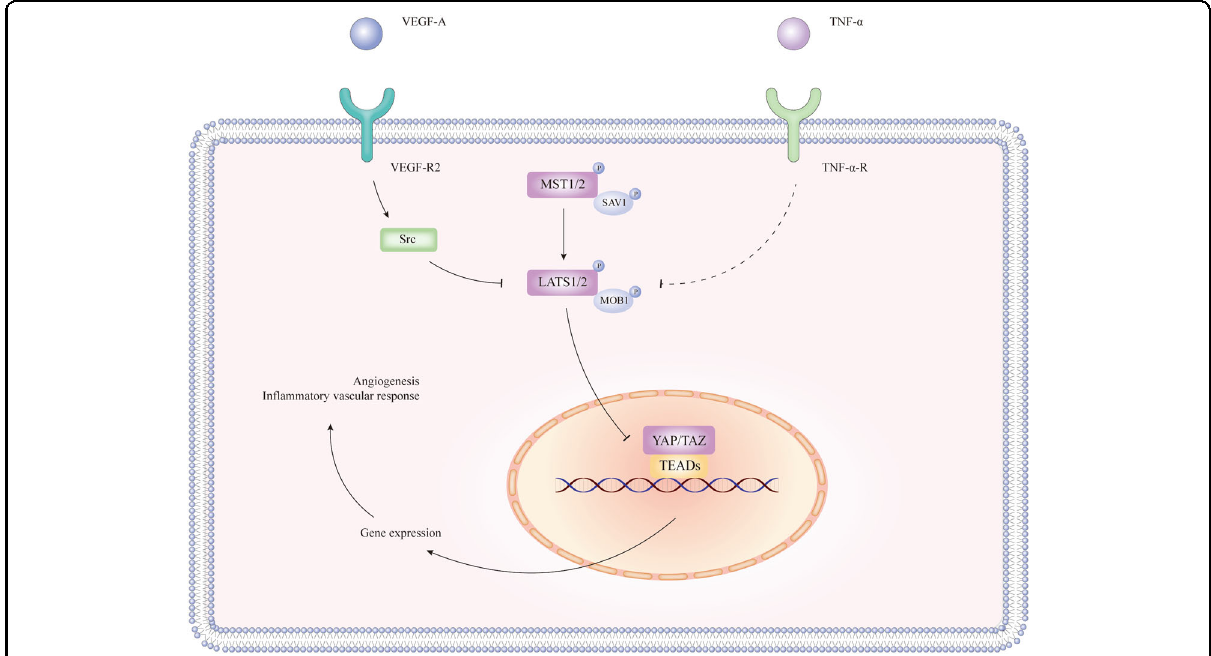
Fig. 4 The regulation of VEGF-A and TNF-a in the Hippo pathway. VEGF-A exposure to ECs and binding with VEGFR2 may inhibit the function of LATS1/2 through Src kinase, thus relieving YAP/TAZ from inhibition and phosphorylation by LATS1/2. The complex of TNF- α and TNF- α -R may also inhibit the activity of LATS1/2 indirectly. Activated YAP/TAZ accumulates in the nucleus and promotes angiogenesis and/or in fl ammatory vascular response. Arrows, blunt ends, and dotted lines indicate activation, inhibition, and possible regulatory effect,